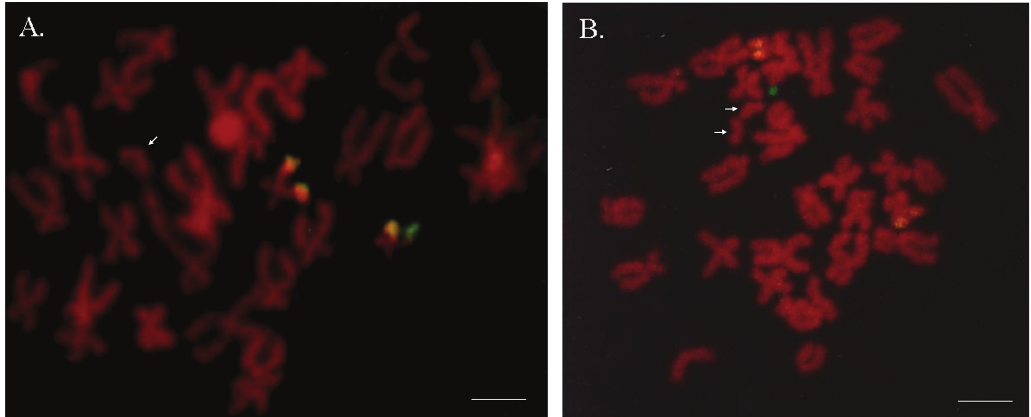
Figure 3 - D. nanus mitotic metaphases with one (A) and two (B) B-chromosomes (arrows) after fluorescence in situ hybridization to Xenopus laevis rDNA probe. No FISH signals were detected on the B-chromosomes. Bar = 5 µ m.